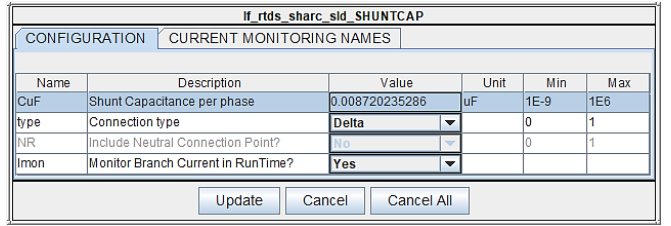
Figure 24. WPP terminal reactive power compensator device model settings parameters. Only one unit is shown in this part, though all other units have the same settings menu, with different labeling of signals.